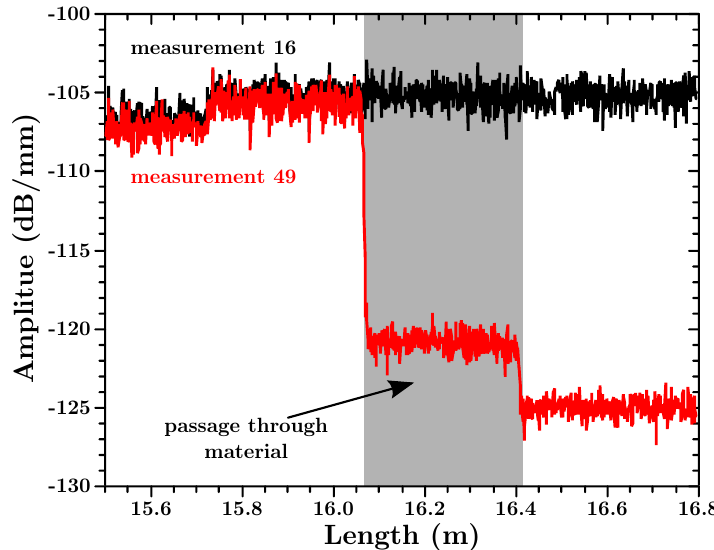
Figure 5. Amplitude of the backscattered signal for different measurements. To be able to determine at which position the steps occur, the length in this figure is given as the absolute length from the OBR instrument and not as the relative length, as seen from the entry point of the fiber into the epoxy. Measurement times: #16 → 200min, #49 →